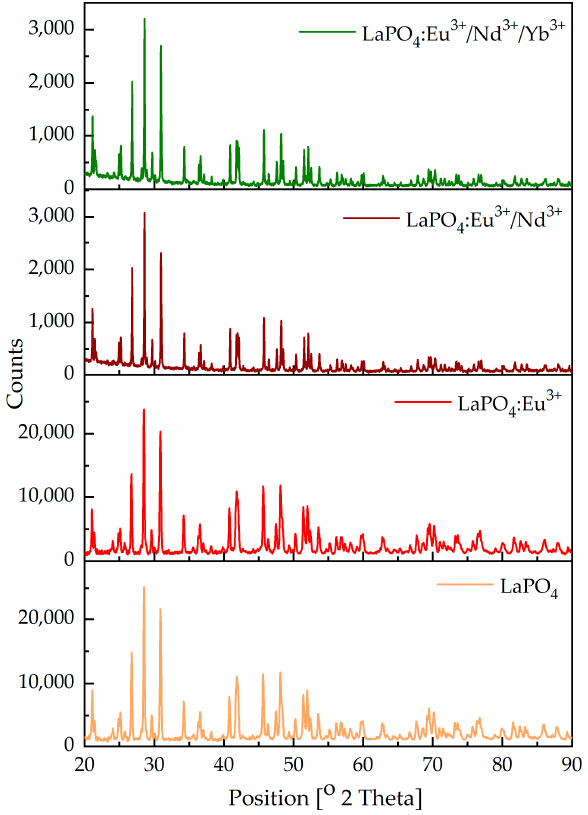
Figure 1. XRD measurements of LaPO 4 , LaPO 4 :Eu 3+ , LaPO 4 :Eu 3+ /Nd 3+ , and LaPO 4 :Eu 3+ /Nd 3+ /Yb 3+ .